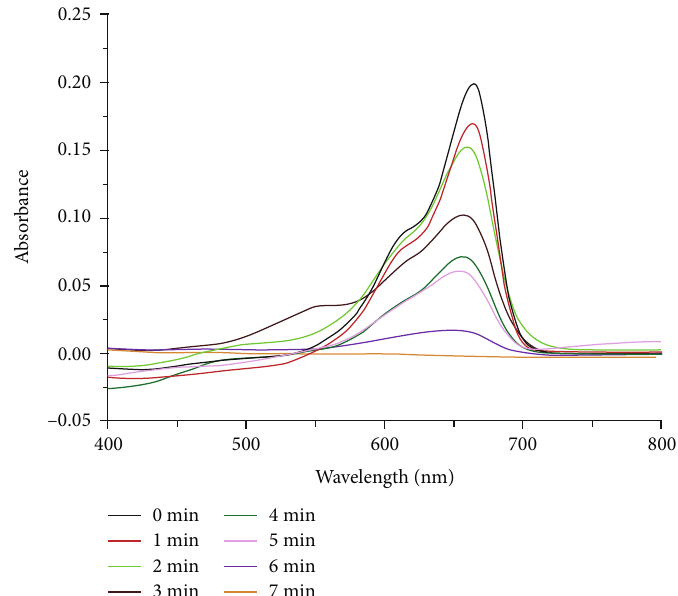
Figure 8: Ultraviolet – visible (UV – vis) spectra of a mixture of methylene blue dye ( 2 × 10 − 5 M , 2 ml aqueous solution) and reducing agent NaBH (0.1M, 1ml) in the presence of Ag/POM/ β -CD micro fi bers ’ fi lm with di ff erent reaction 4